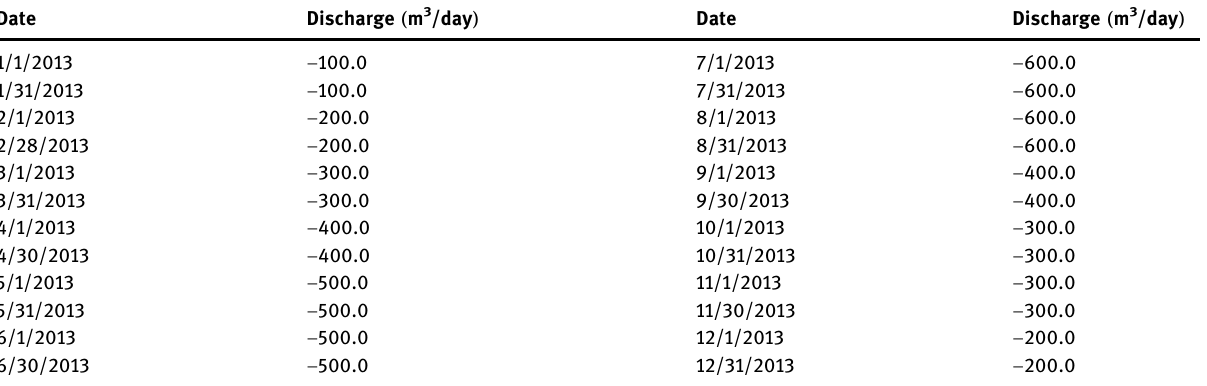
Table 5: Pumping data for